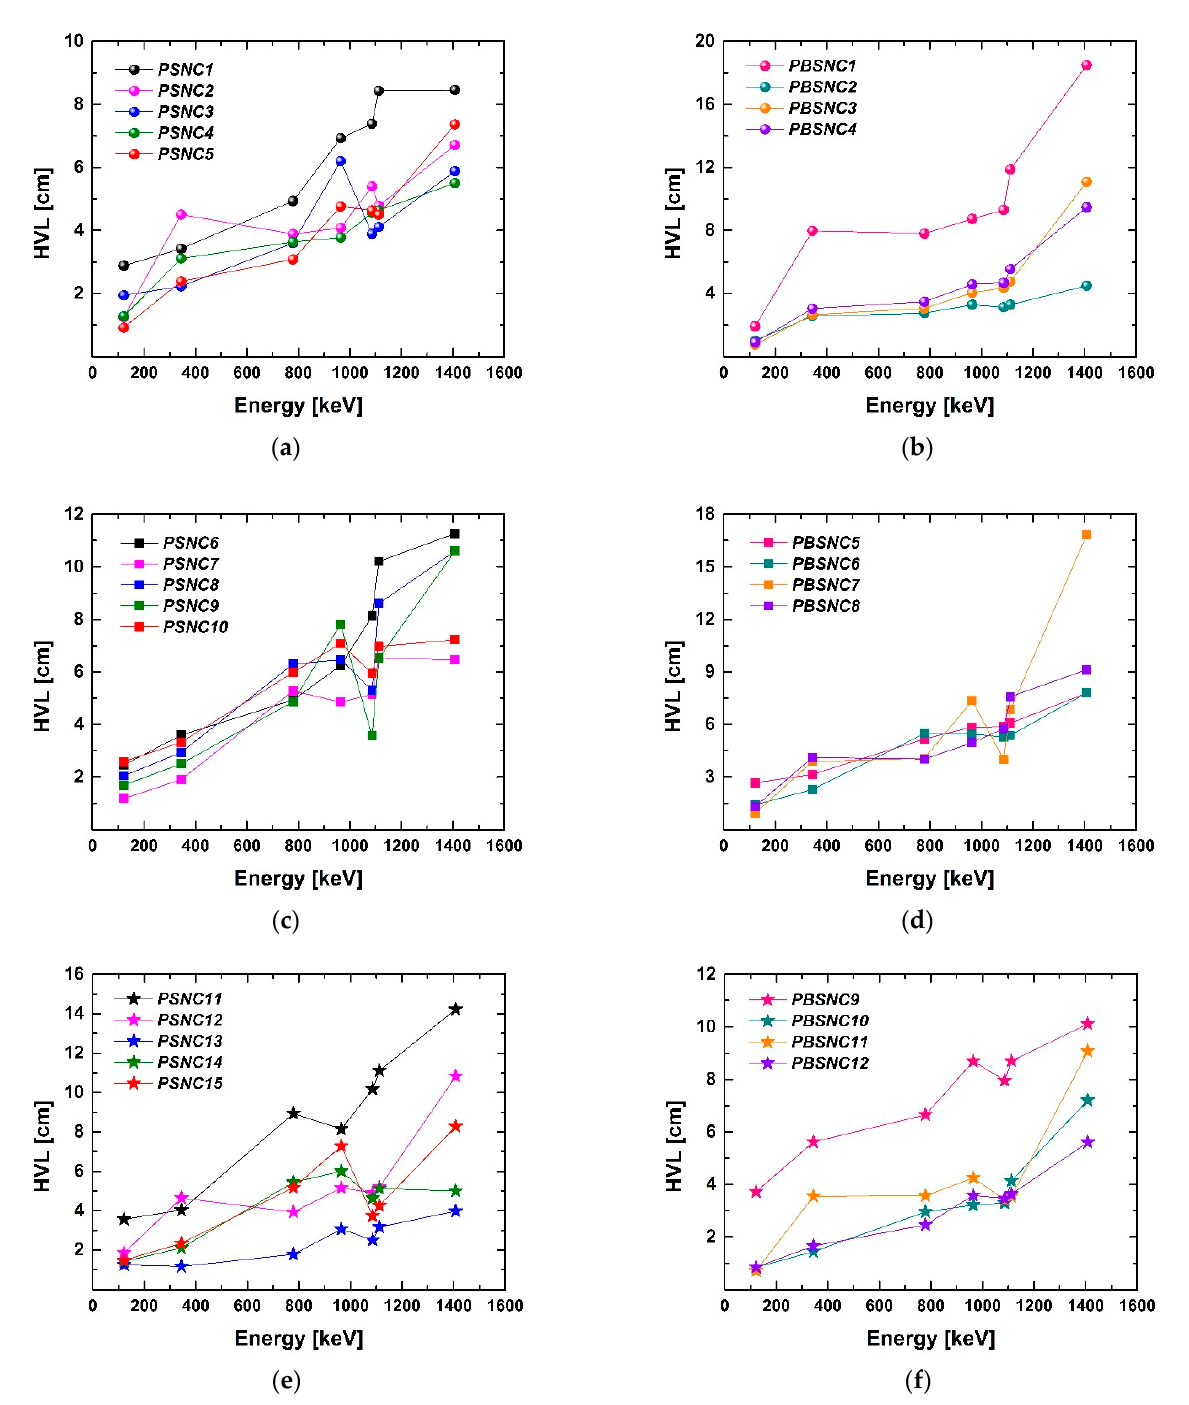
Figure 9. The HVL values of the PS-b-PEG copolymers blended with the nanostructured SeO 2 and BN particles under a wide range of gamma irradiation energies: PSNC1, PSNC2, PSNC3, PSNC4, and PSNC5 ( a ); PBSNC1, PBSNC2, PBSNC3, and PBSNC4 ( b ); PSNC6, PSNC7, PSNC8, PSNC9, and PSNC10 ( c ); PBSNC5, PBSNC6, PBSNC7, and PBSNC8 ( d ); PSNC11, PSNC12, PSNC13, PSNC14, and PSNC15 ( e ); PBSNC9, PBSNC10, PBSNC11, and PBSNC12 ( f ). The HVL rates are a crucial indicator of the shielding ability; that is, it can be said that the smaller the HVL rate of the material, the better the radiation attenuation. Thus, the HVL rates of our nanocomposites increase as the gamma-ray energy increases. In the range from 121.788 keV to 1408.006 keV of the 152 Eu source, when we viewed the sequence of HVL values for the PS-PEG (1000), PS-PEG (1500), and PS-PEG (10,000) copolymers